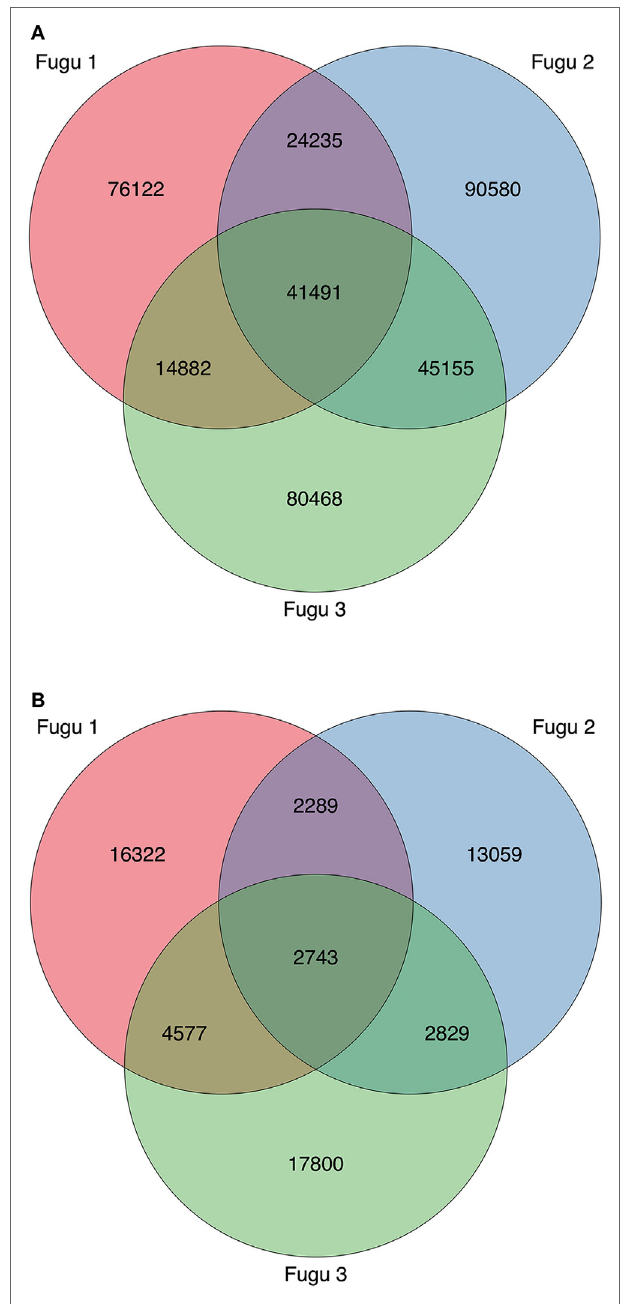
FigUre 6 | Profile and overlap of heavy (H) chain complementarity- determining region 3 (CDR-H3) cluster abundance across the three torafugu. (a) IgM and (b) IgT. The Venn diagram corresponds to Table 3 showing the cluster sequence